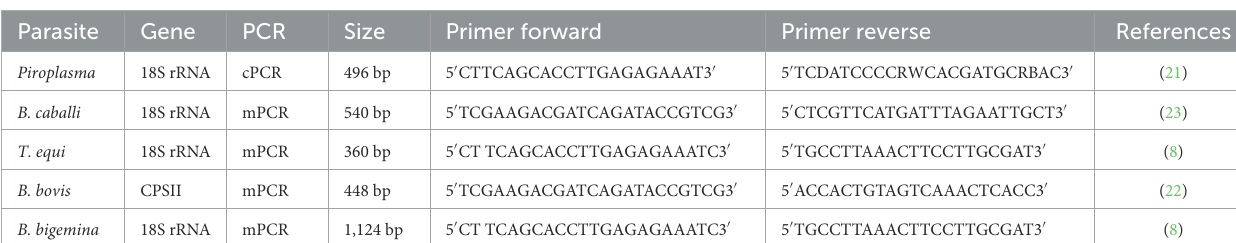
TABLE 1 Oligonucleotide primers used in conventional and multiplex